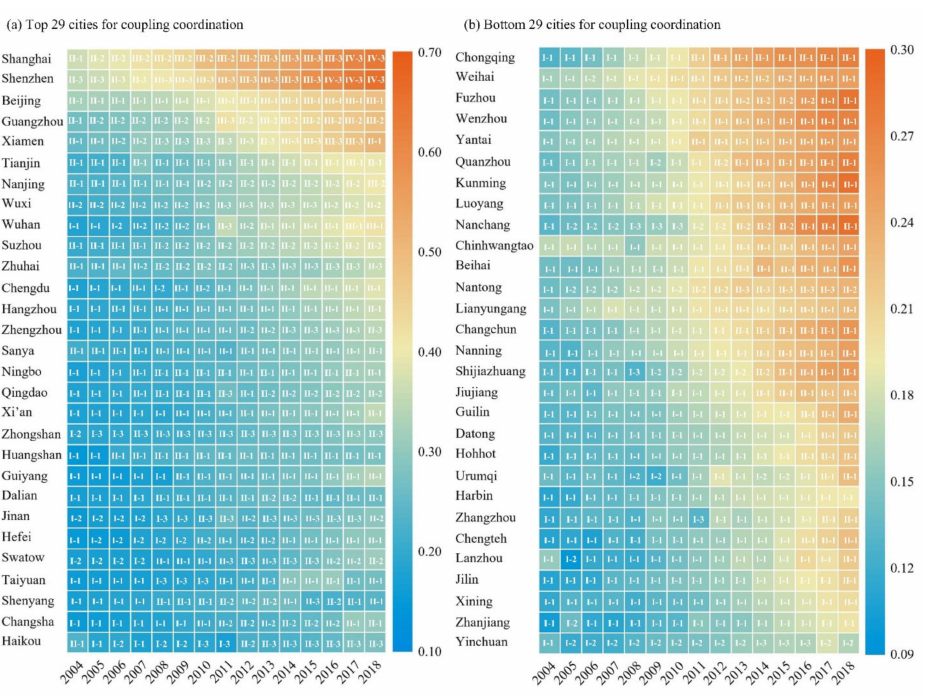
Figure 8. Variation in coupling coordination type and relative development type between ILU and TID in 58 major tourist